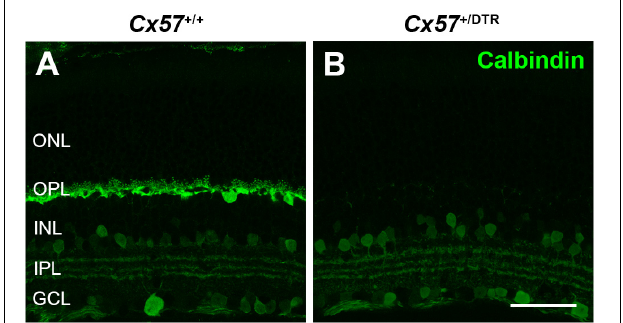
FIGURE 1 | Horizontal cell ablation. (A,B) Retinal cryosections of Cx57 + / + and Cx57 + / DTR mice (P56) were labeled with an antibody specific for the horizontal cell marker calbindin. In Cx57 + / DTR mice, horizontal cells were completely lost, while calbindin-positive amacrine and ganglion cells were unaffected (B) . Scale bar, 50 µ